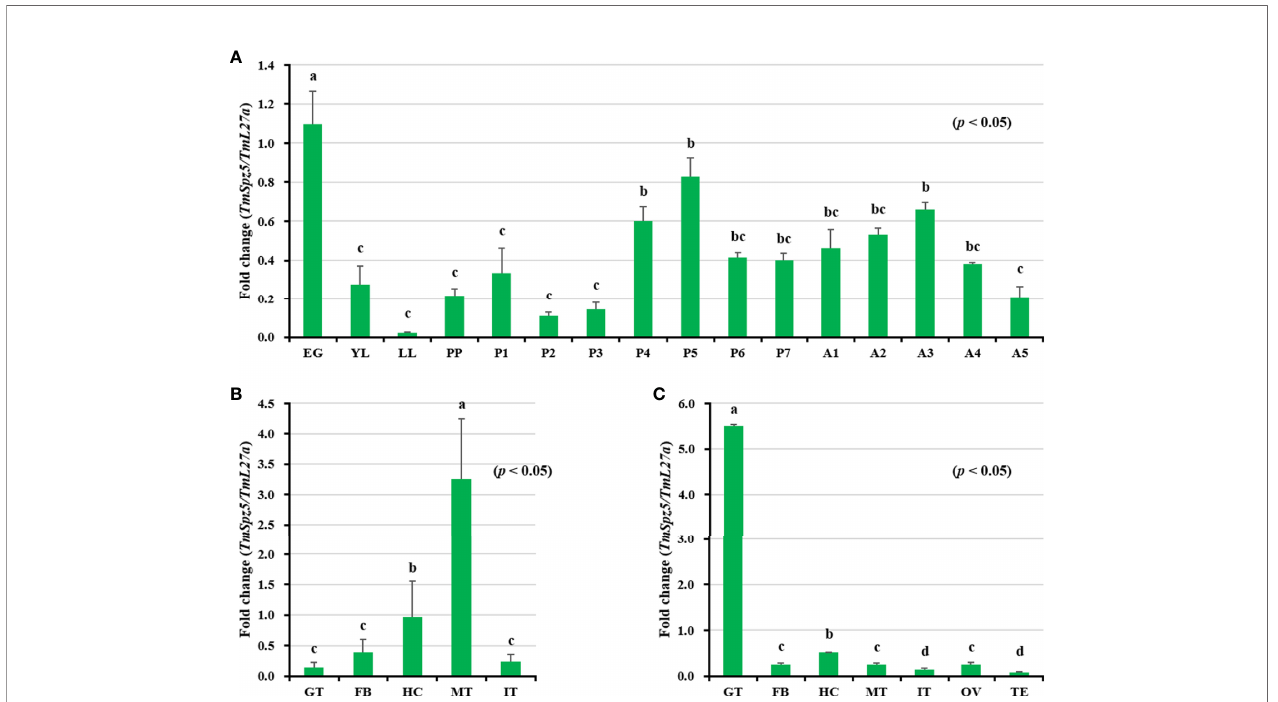
FIGURE 3 | Developmental stage- and tissue-speci fi c expression patterns of TmSpz5 measured by qRT-PCR. (A) Relative TmSpz5 mRNA levels in eggs (EG), young larvae (YL), late-instar larvae (LL), pre-pupae (PP), 1- to 7-day-old pupae (P1 – P7), and 1- to 5-day-old adults (A1 – A5) are illustrated. Expression levels were the highest in the eggs and the pupae. The mRNA levels decreased in the larval stage and were lowest in the late larval stage. Increases in TmSpz5 transcript levels were detected during molting and in each ecdysis with a gradual decrease across each individual stage. TmSpz5 tissue expression patterns in late instar larvae (B) and adults (C) were also examined. Total RNA was extracted from different tissues, including the integument (IT), Malpighian tubule (MT), gut (GT), hemocytes (HC), and fat bodies (FB) of late instar larvae and the integument (IT), Malpighian tubule (MT), gut (GT), hemocytes (HC), fat bodies (FB), ovary (OV), and testis (TE) of 5-day-old adults. Total RNA was isolated from 20 mealworms and T. molitor 60S ribosomal protein 27a ( TmL27a ) primers were used as internal control (N = 3). One-way ANOVA and Tukey ’ s multiple-range test at a 95% con fi dence level were used for comparisons. Bars with the same letter are not signi fi cantly different by Tukey ’ s multiple-range test ( p < ( Figure 4C ), and MTs ( Figure 4D ), were collected at 3, 6, 9, 12, and 24 h post-pathogen injection for total RNA extraction.